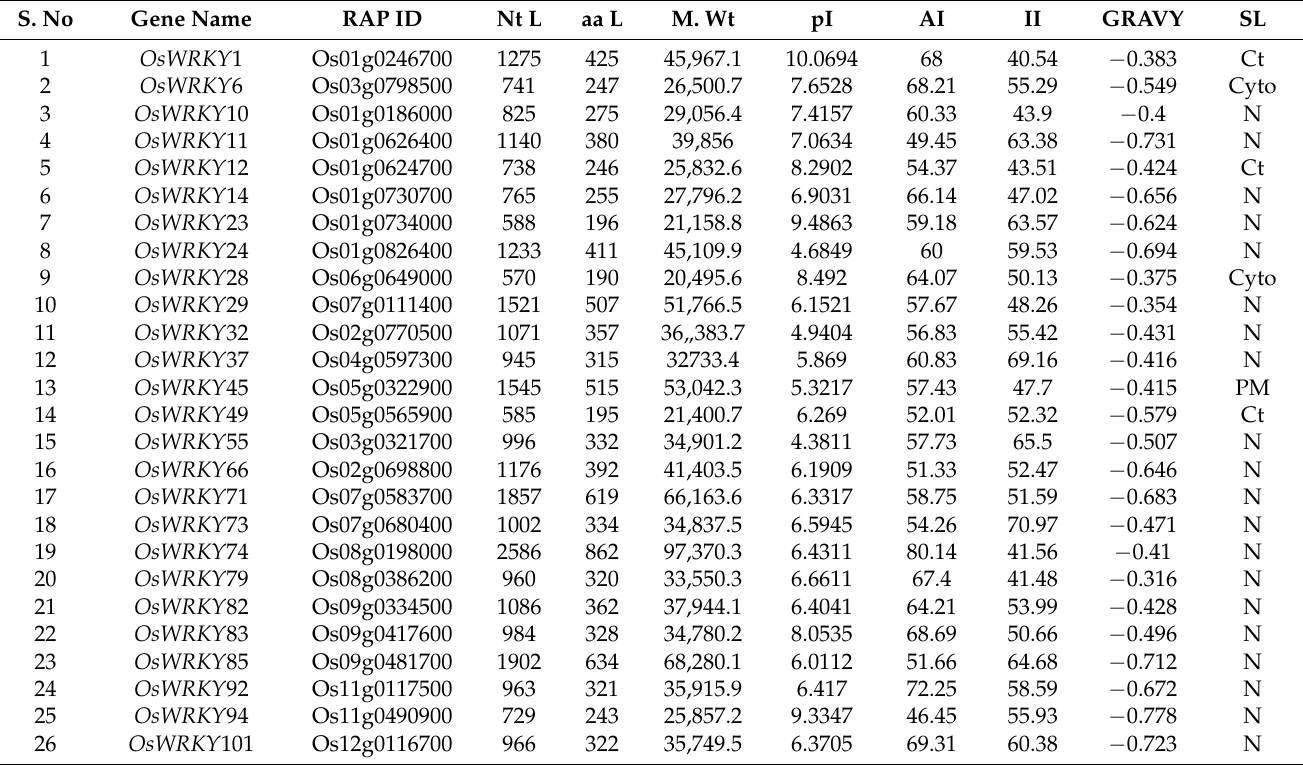
Table 2. Details of OsWRKY genes and their